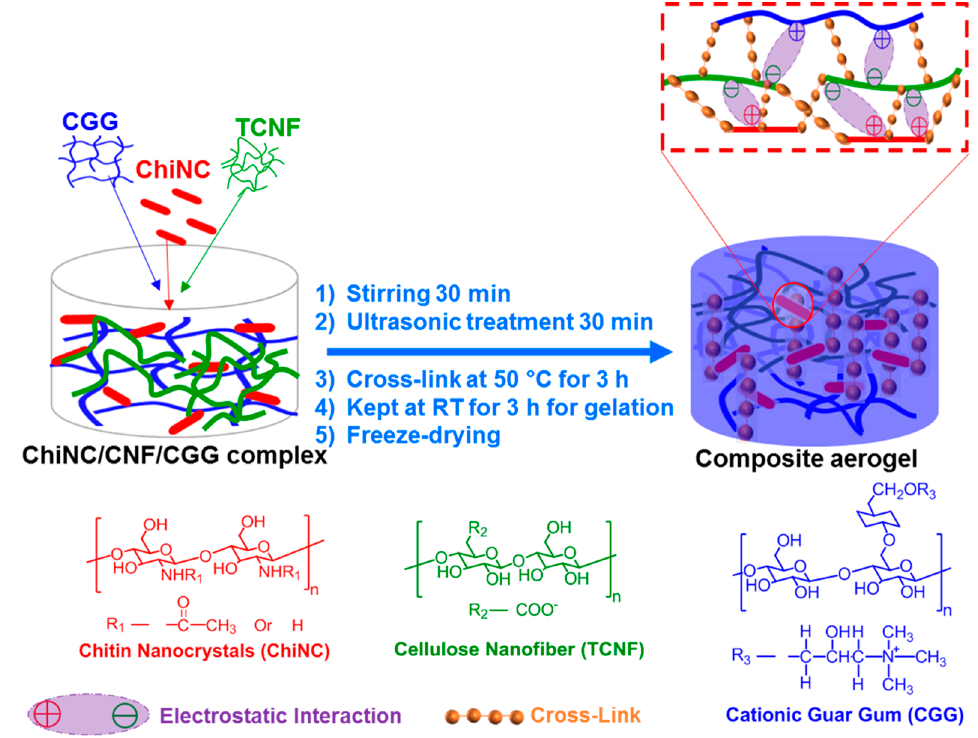
Figure 2. Schematic of preparation of the cross-linked chitin nanocrystals (ChiNC)/cellulose nanofibers (TCNF)/cationic guar gum (CGG) aerogel.